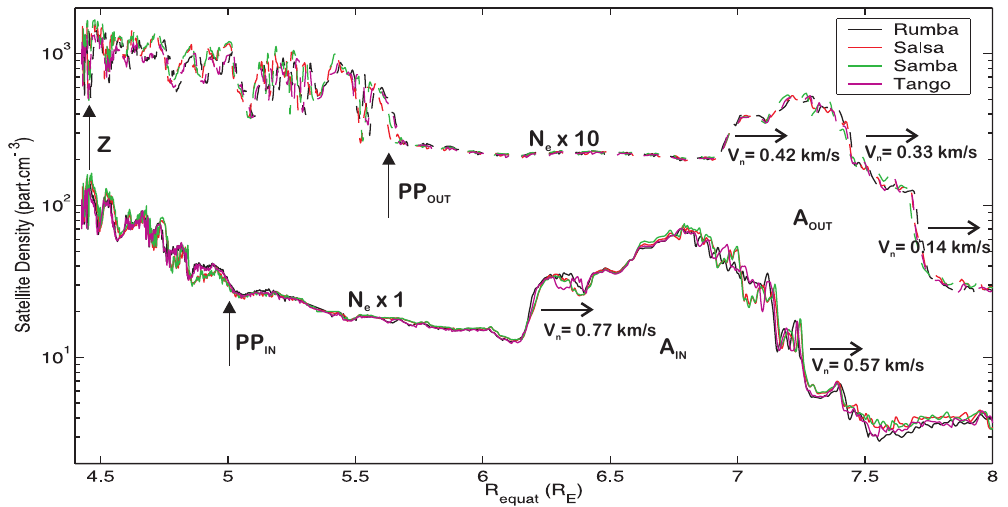
Fig. 4. Electron density profiles as a function of R equat for the plasmasphere crossing on 11 April 2002. The lower four curves correspond to the inbound pass and the upper four curves (shifted by a factor 10) to the outbound pass. The normal boundary velocities V n of the plume crossings A IN and A OUT are indicated on the